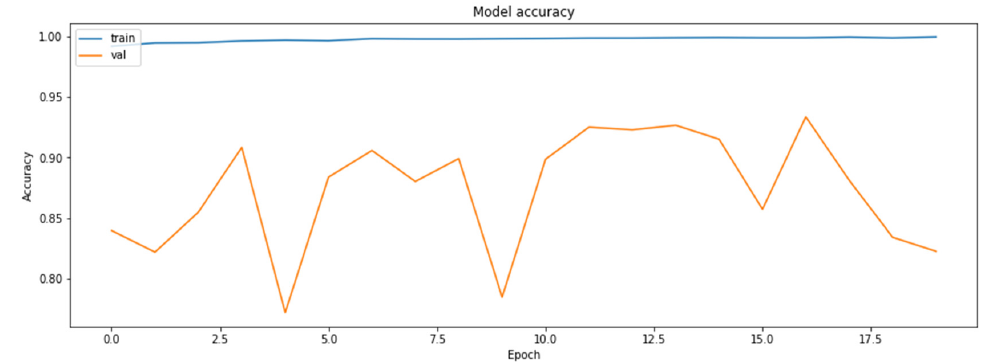
Figure 4. The accuracy of the model on the training and the validation datasets by polynomial iterative model.